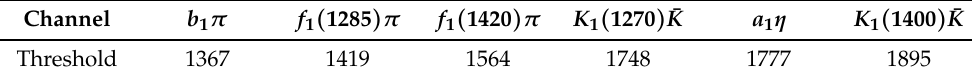
Table 2. J PC = 1 − + meson–meson channels with I = 1. The threshold masses are in the units of MeV.